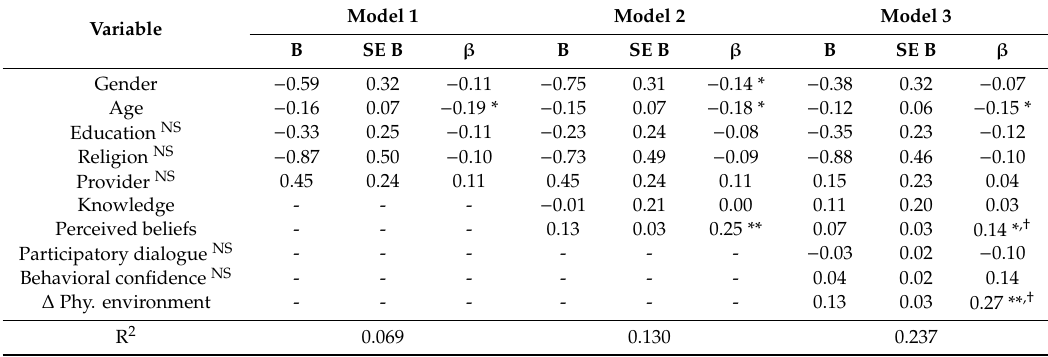
Table 3. Summary of hierarchical multiple regression analyses for covariates and MTM constructs predicting adolescents’ likelihood of getting first dose of HPV vaccination ( n = 285). Model Variable